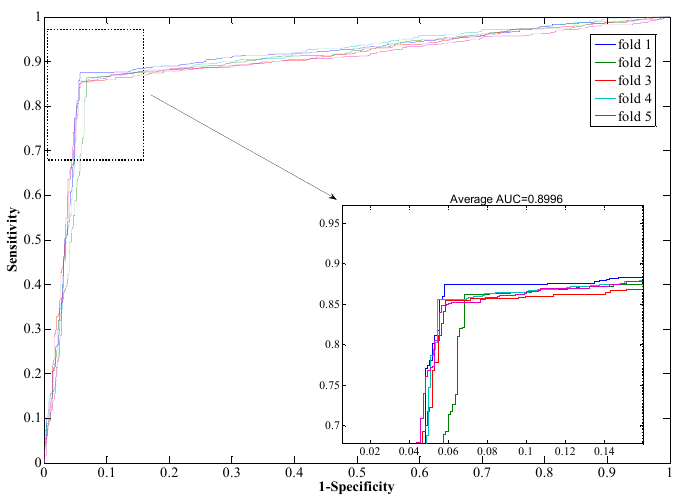
Figure 5. ROC from SVM-based method result for Human PPI dataset.